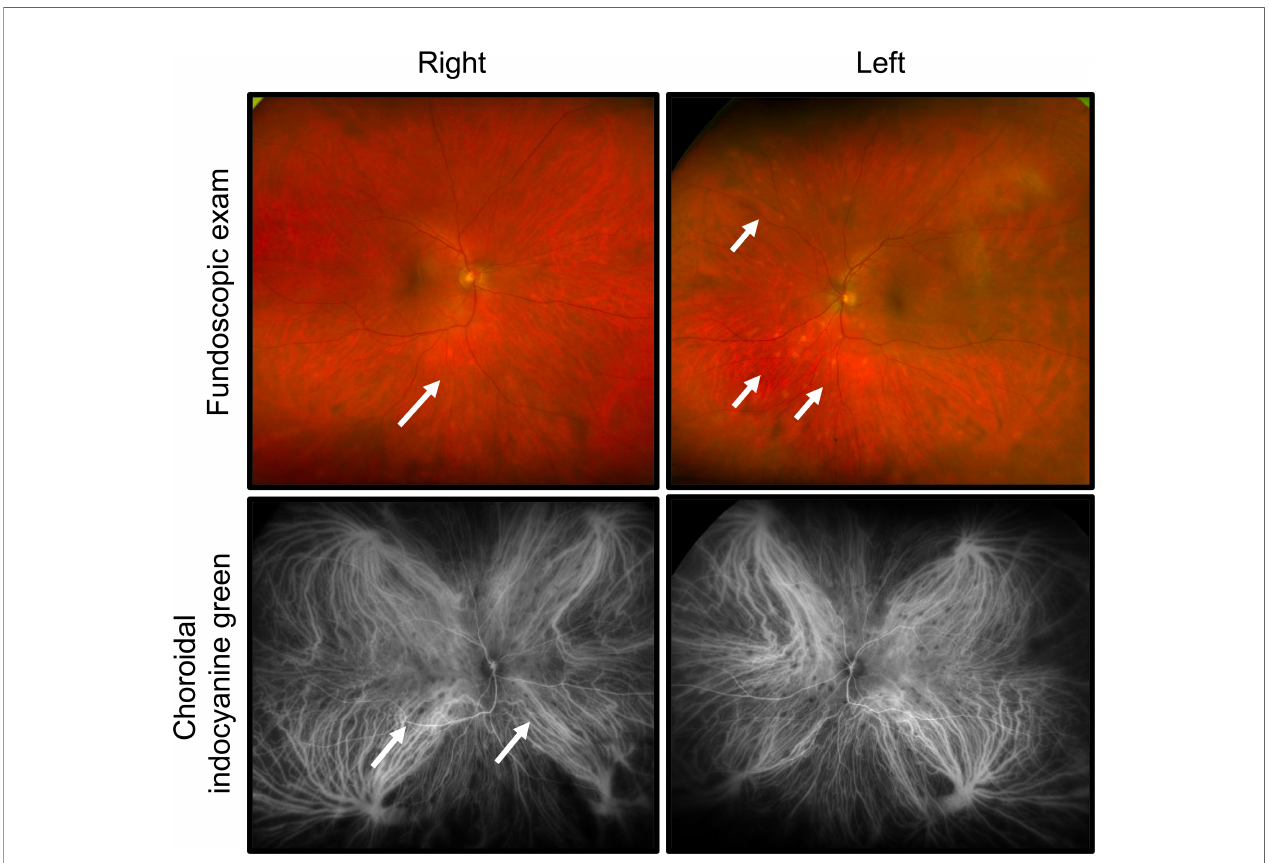
FIGURE 2 | Development of bilateral panuveitis during treatment with encora fi nib/binimetanib. Fundoscopic exam revealed hypopigmented lesions bilaterally. In the right eye, hypopigmented lesions were identi fi ed along the inferior arcade and yellow hypopigmentation was seen superior/inferior arcades. In the left eye, hypopigmented spots were appreciated along the inferior arcade. Choroidal indocyanine green angiography identi fi ed diffuse choroidal involvement with patchy areas of